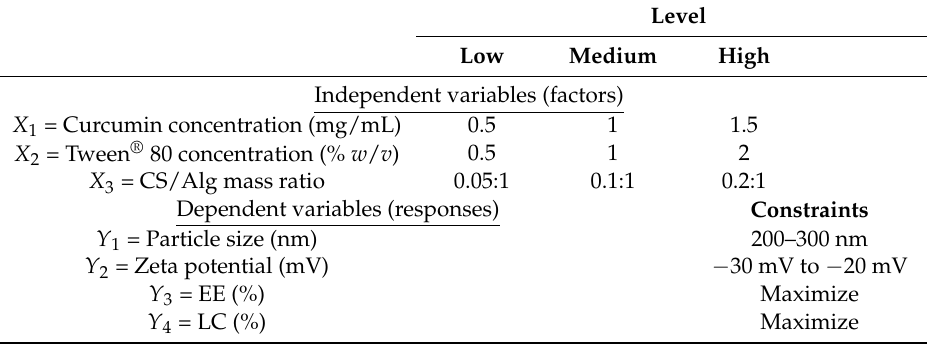
Table 5. Variables and responses with their levels and